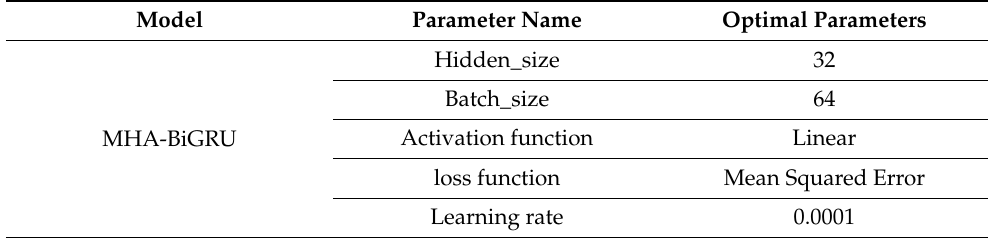
Figure 5. Model training over time, where the blue block represents the input training data and the green one represents the prediction result for each batch of input. Table 1. The hyper parameters selection of comparative